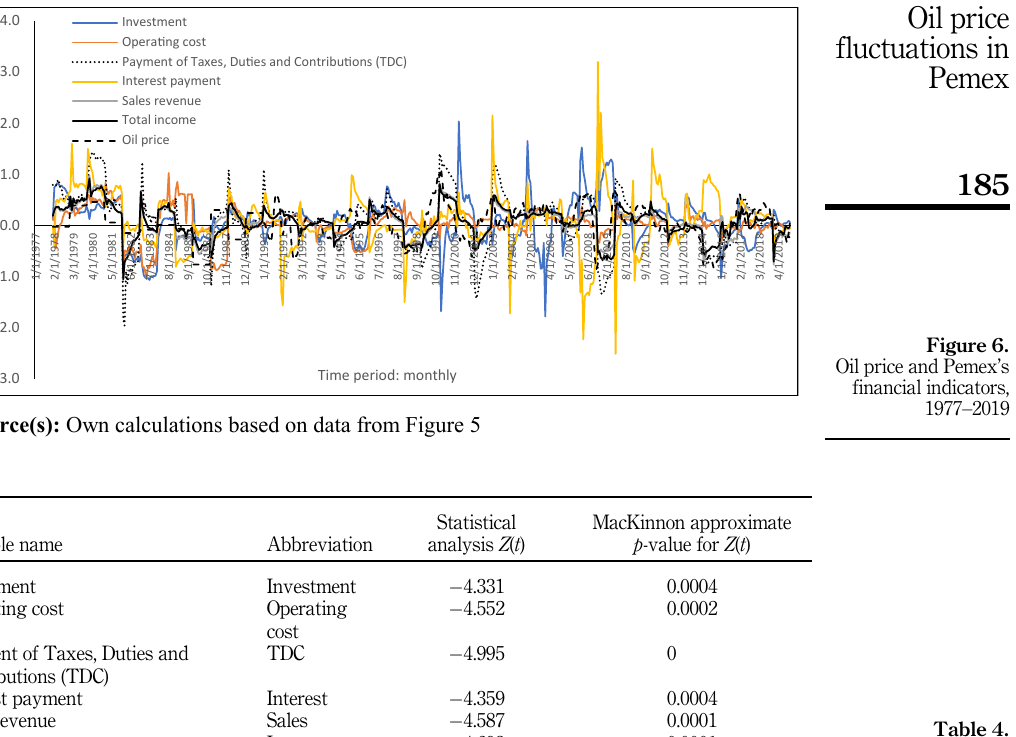
Table 4. Results of